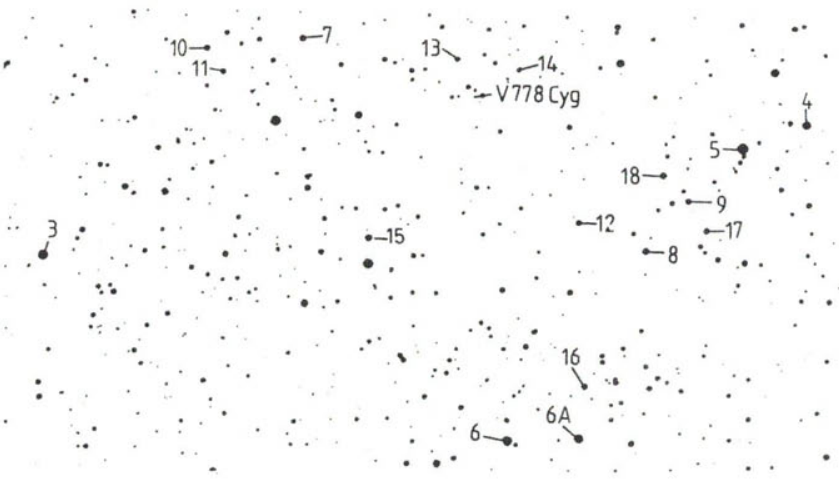
Fig. 3. Finding chart for V778 Cyg and comparison stars. The stars Nos. 1 and 2 are out of the